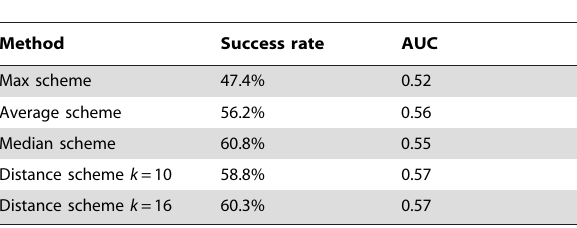
Table 5. The AUC and success rate for the prediction of the B-cell epitopes on the SEQ194 dataset when using predictions from the SVM model with 84 features and the five schemes: maximum, average, median, and distance scheme with k = 10 and k = 16. We use the Filtered40_BCPREDFrag to generate the SVM